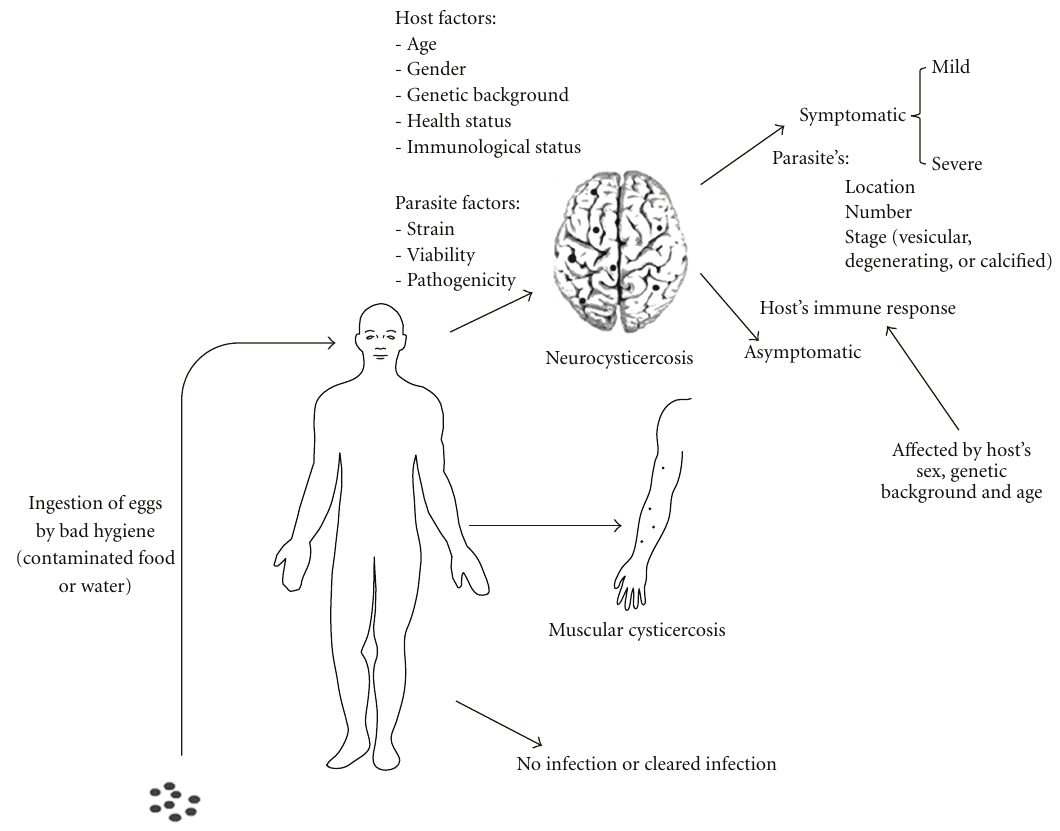
Figure 1: Factors involved in NCC. The development of NCC depends on many factors from either the host or the parasite. The factors a ff ecting the immune response of the host are particularly important for the immunodiagnosis of NCC as they may a ff ect the results between